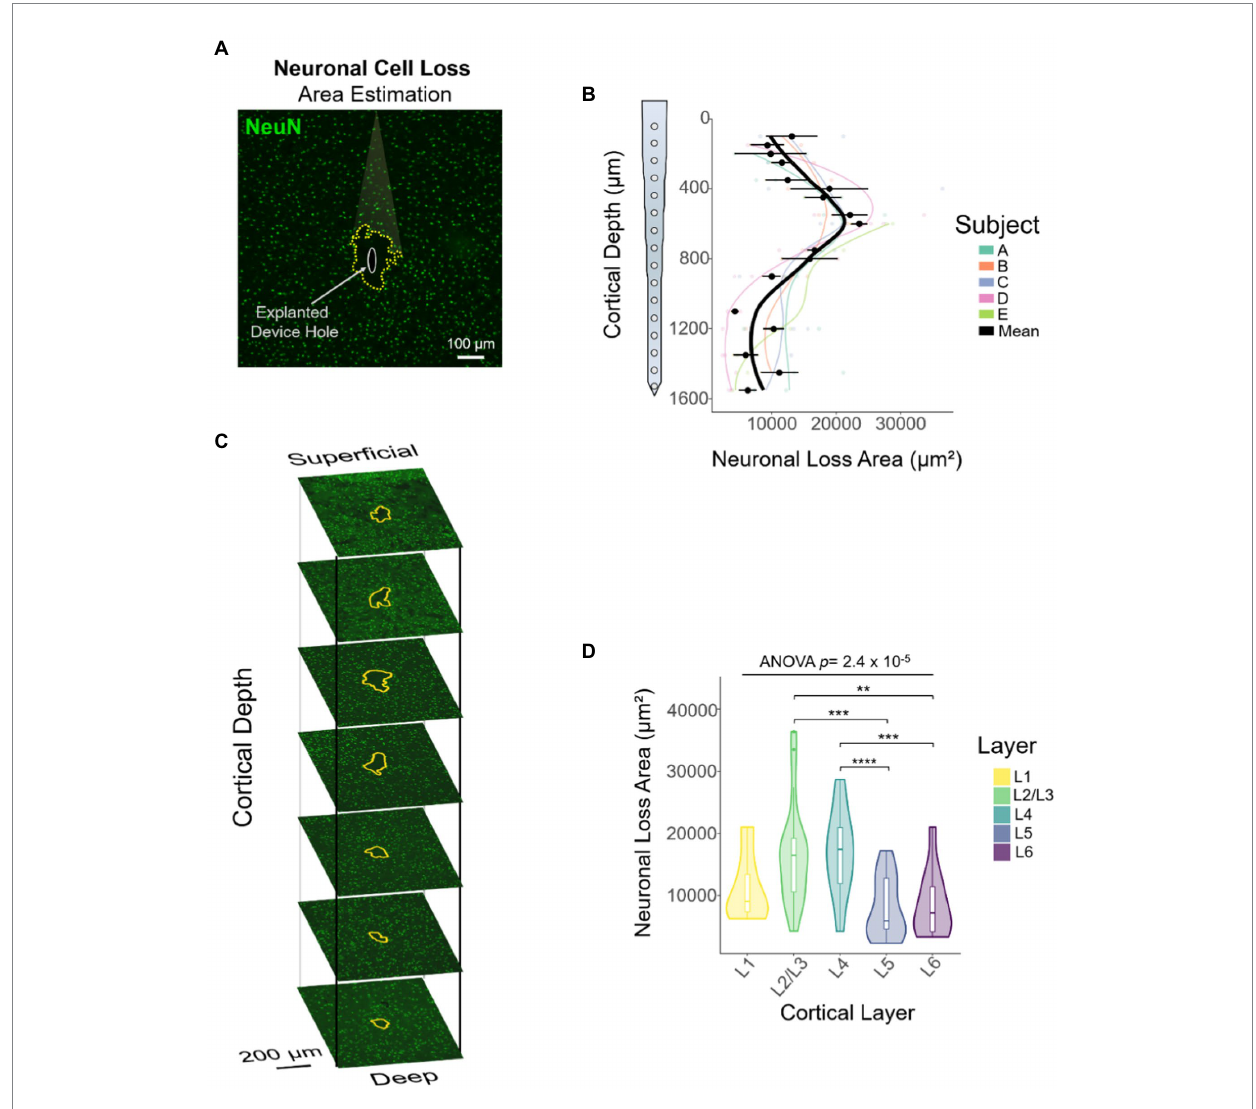
FIGURE 7 Quantification of neuronal cell loss area across cortical depth using DeepHisto. (A) The area of neuronal cell loss was manually assessed by blinded evaluators. Yellow dotted outline represents the estimate of area of neuronal cell loss surrounding the explanted electrode (white oval). (B) Representative DeepHisto stacks of cortical slice histological analysis across cortical depth for one animal. Yellow outlines represent neuronal cell loss surrounding the explanted electrode. (C) Quantification of neuronal cell loss area across cortical depth. Colored lines represent locally fitted polynomial regressions for each subject and black line represents the mean ( N = 5). (D) Quantification of neuronal cell loss area across cortical layers (one-way ANOVA) and pairwise comparisons between layers (unpaired t -test followed by Dunn–Bonferroni’s correction). * p ≤ 0.05, ** p ≤ 0.01, *** p ≤ 0.001, **** p ≤ 0.0001. Error bars indicate mean ±